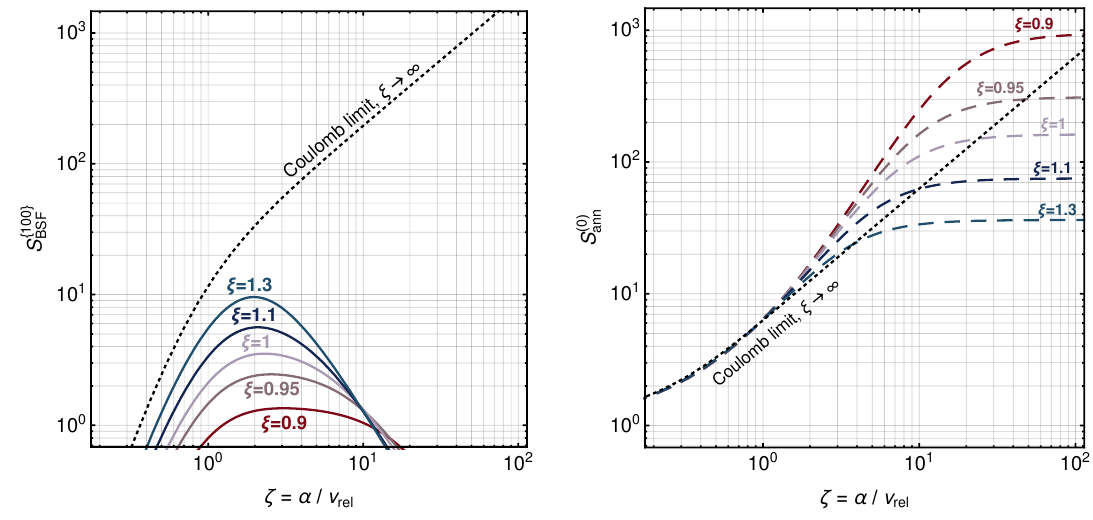
Figure 3d . Left: for (cid:24) values close to the threshold for the existence of a bound state, the cross- section for the radiative formation of this bound state is suppressed with respect to its Coulomb value, for all velocities. This suppression arises from the bound-state wavefunction, which becomes very extended for (cid:24) values near threshold, and is independent of the phase-space suppression due to the emission of a massive force mediator. Right: the same values of (cid:24) yield a resonance in the annihilation